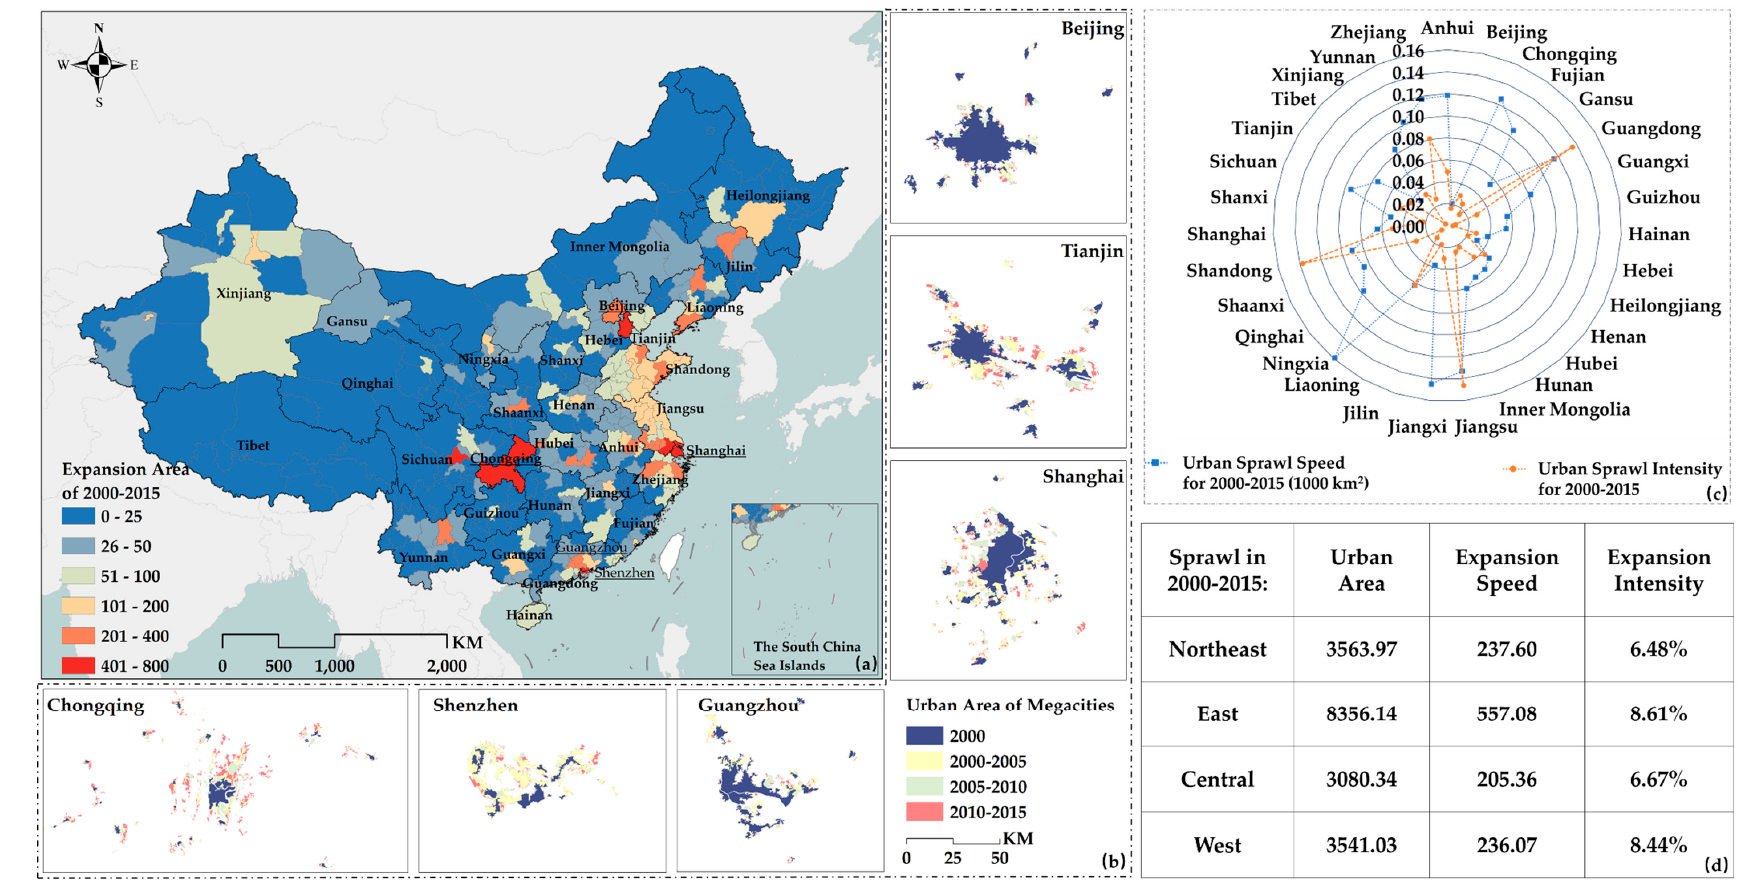
Figure 9. Spatiotemporal distribution map of urban expansion of China’s cities in 2000–2015. Urban area and expansion area unit: km 2 , Expansion speed unit: km 2 per year .